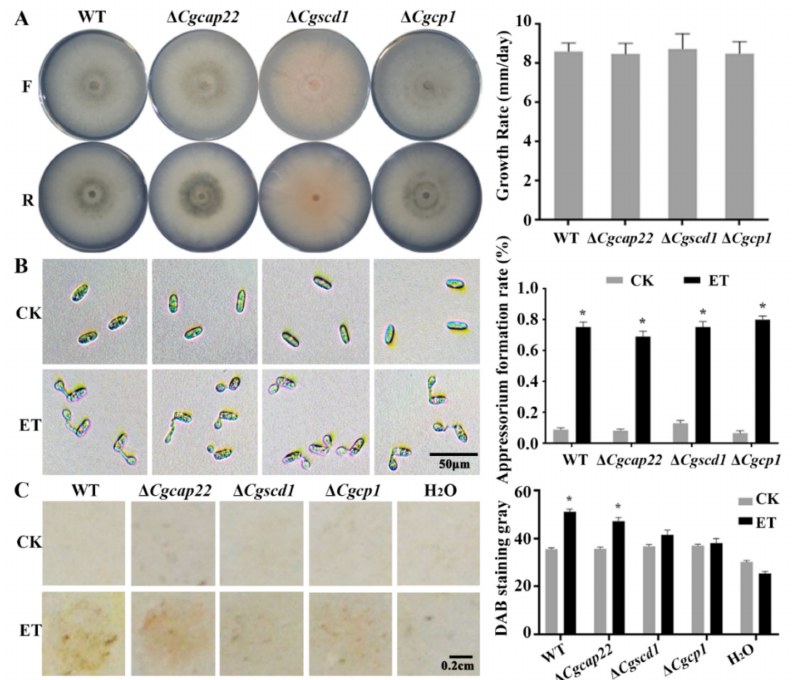
Figure 6. Phenotypic characterization of three mutants with disruption of the ET-responsive genes including CgCAP22 , CgSCD1 , and CgCP1 . ( A ) The left two rows of photos demonstrate the front (F) and reverse (R) sides of the fungal colonies grown on PDA for 5 days; the right bar chart indicates that the colony diameters of the mutants showed no significant difference in comparison with the WT. ( B ) ET significantly promoted the appressorium formation of WT and the mutants in vitro at 4 h after incubation on glass slides. ( C ) ET treatment enhanced ROS accumulation of WT and ∆ Cgcap22 in host leaves, but caused no effect on ∆ Cgscd1 and ∆ Cgcp1 at 24 h after inoculation. For ( B , C ): p < 0.05